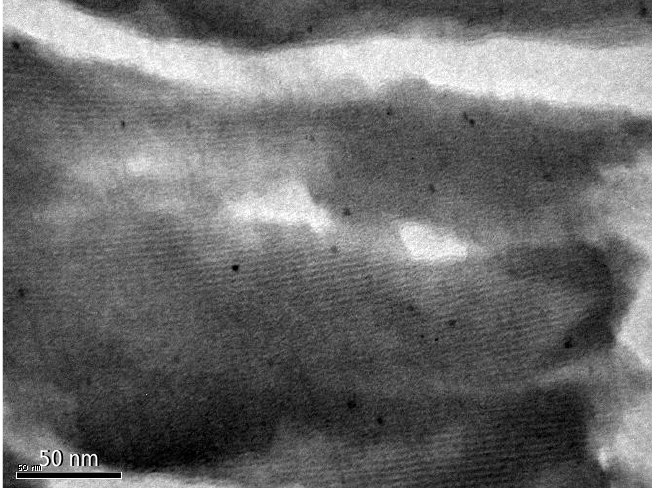
Figure 2. Transmission electron micrographs of Pt(2.5)/CNTsZrO